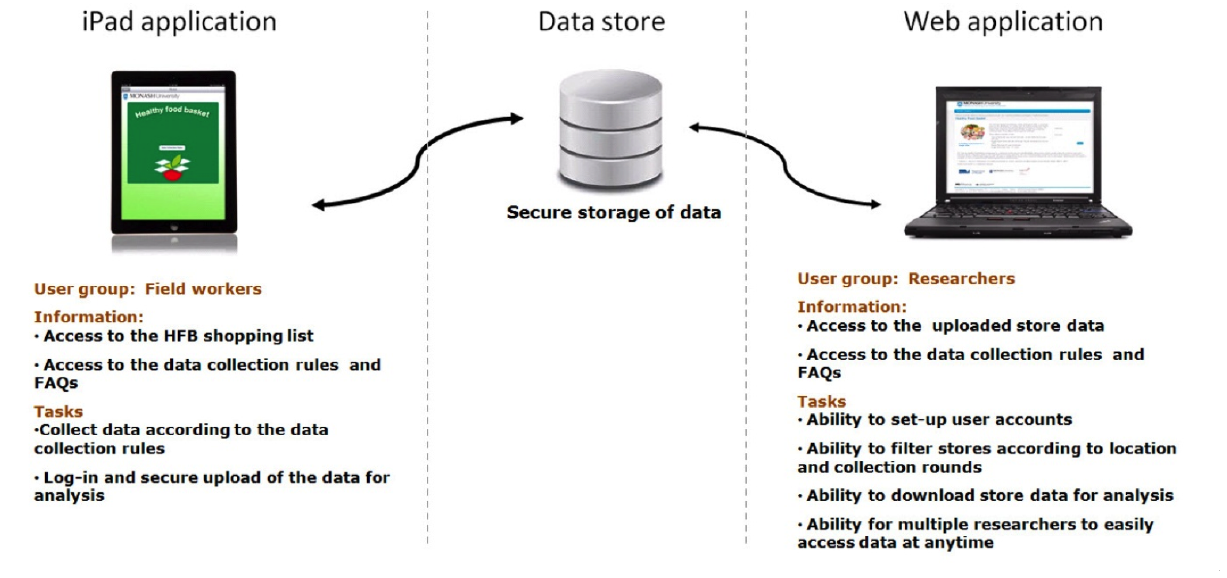
Figure 1. Diagrammatic representation of the technological